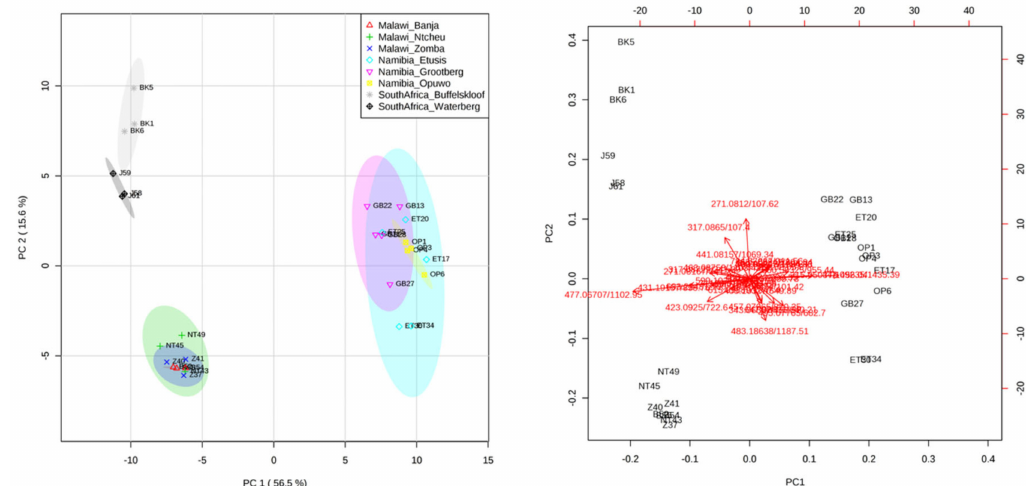
Figure 4. Principal components analysis (PCA) scores plot (left) and loadings plot (right) based on the identified phenolics from the negative ionisation analysis. Fourteen samples from Namibia, nine samples from Malawi, and six samples from South Africa were included in the